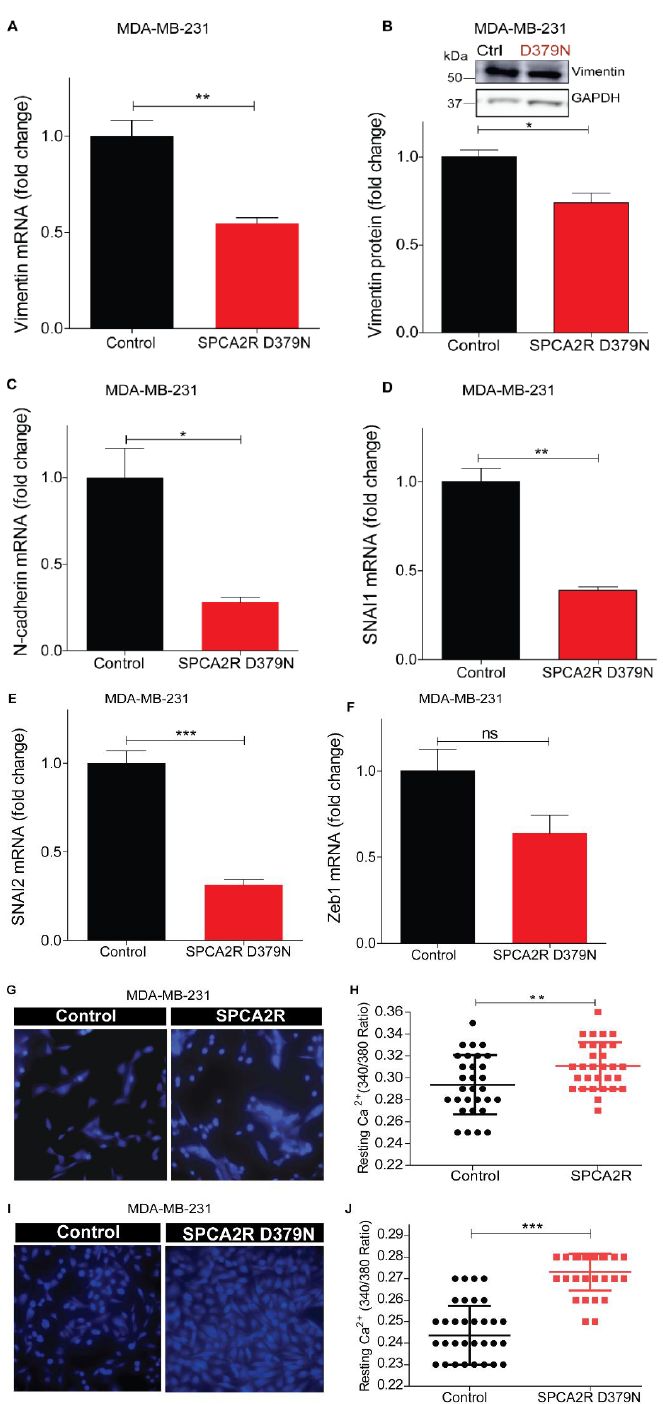
(Figure 5C–F), similar to wild type SPCA2R, reported previously [4].